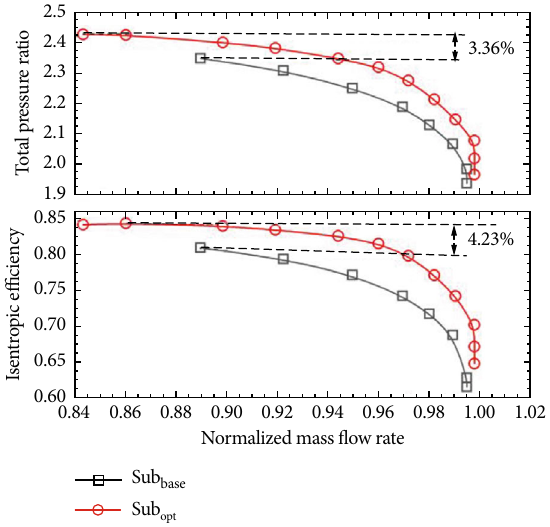
Figure 19: Performance comparisons for the subsonic compressor.